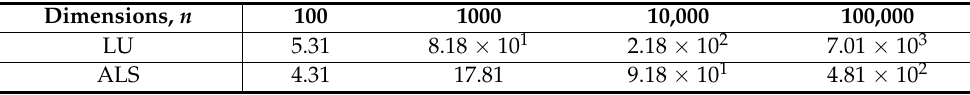
Table 1. Run-times (in seconds) for the factorization of V . Dimensions, n